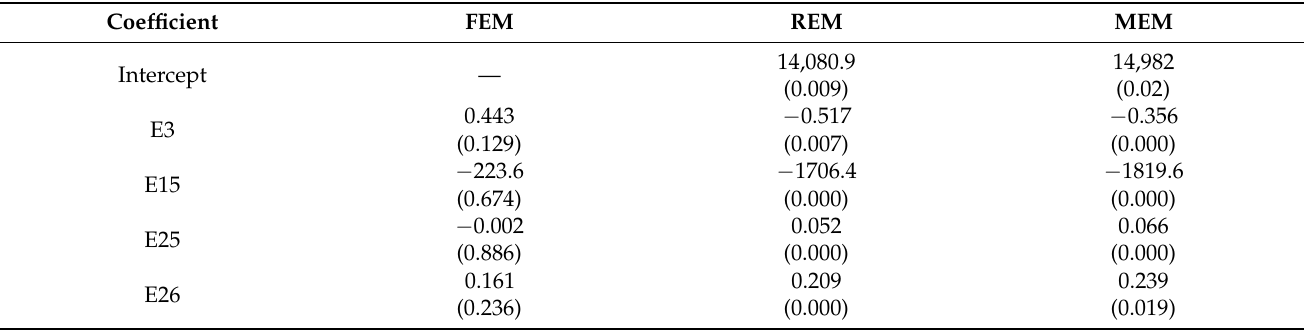
Table 6. Estimation results 1 on parameters in different models.